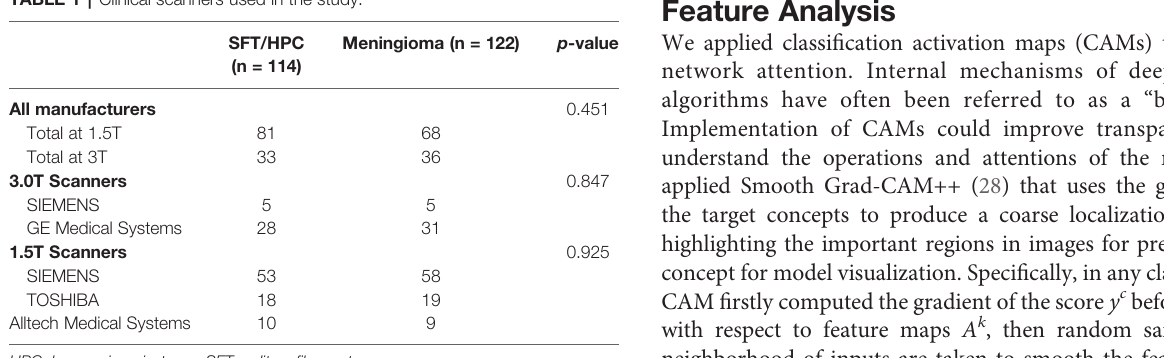
TABLE 1 | Clinical scanners used in the study.